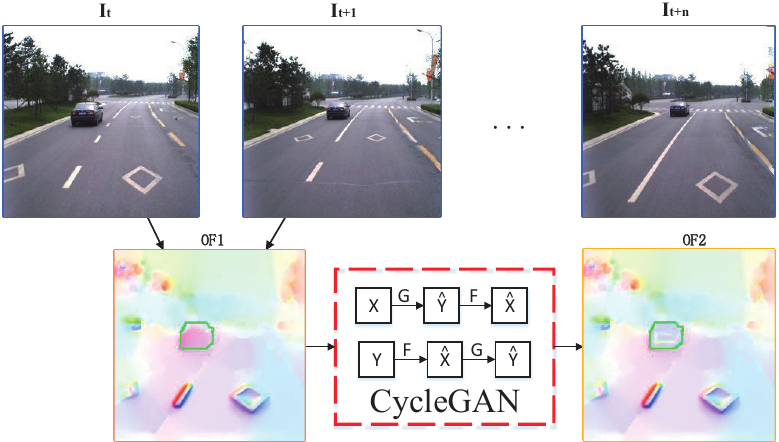
Figure 3. Flow diagram of optical flow